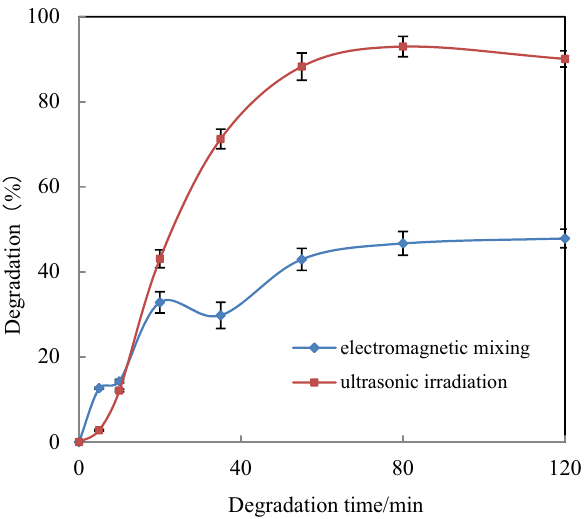
Figure 4. Effect of US irradiation on [C 4 mim][BF 4 ] degradation. ([[C 4 mim][BF 4 ]] = 1 mmol/L, [AC] = 0.15 g, [ZVZ] = 0.15 g, pH = 3.0 at 30 °C).